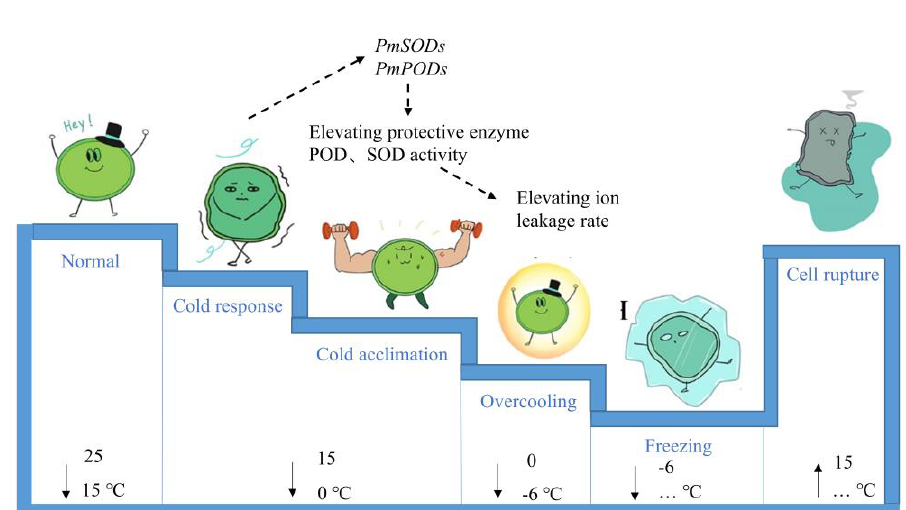
Figure 7. Different stages of low-temperature response of apricot mei XR.